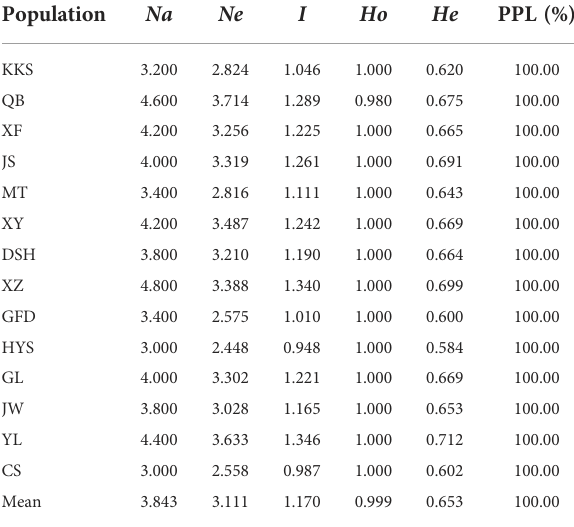
TABLE 6 Polymorphism analysis of 14 Ch. utilis populations based on EST-SSR.